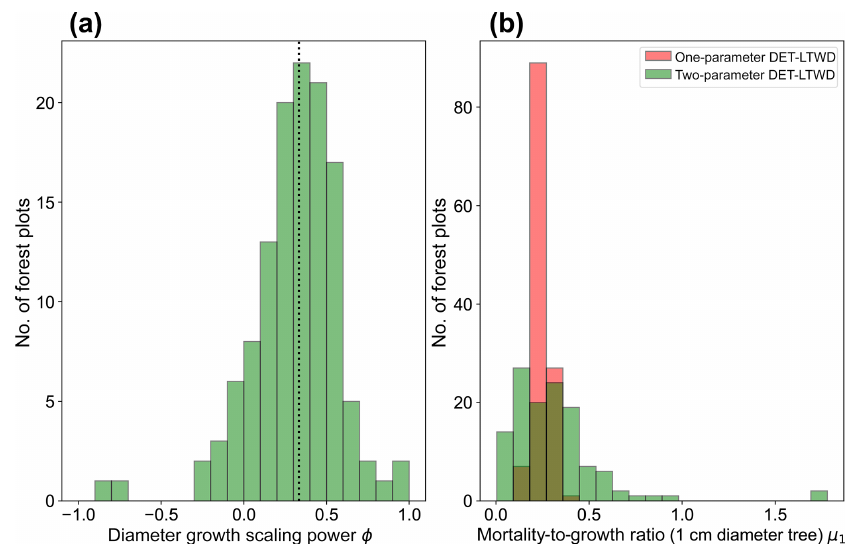
Figure 4. (a) Results for the growth scaling power φ when fitting the two-parameter DET-LTWD via MLE for trunk diameter data from all 124 individual forest plots. The vertical black dotted line shows the value φ = 1 / 3 predicted by MST allometry. (b) Results for the fitted mortality-to-growth ratio µ 1 for both the one- and two-parameter DET-LTWD via MLE for trunk diameter data from all 124 individual forest plots.